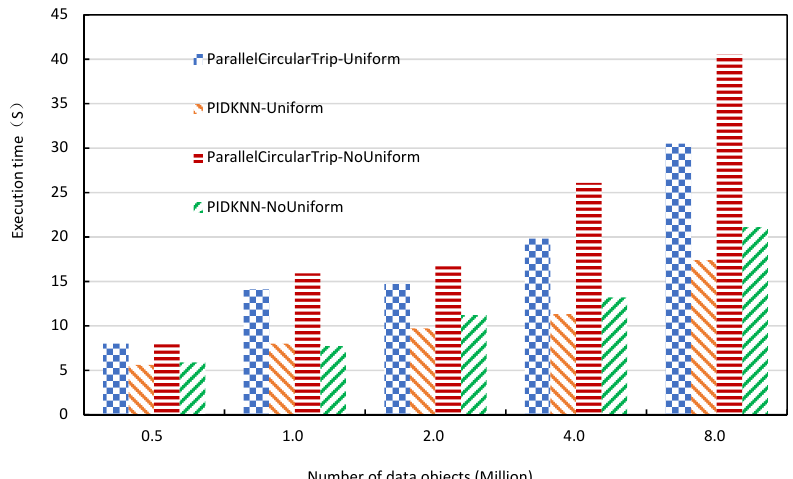
Figure 8. Execution time vs. number of data objects.